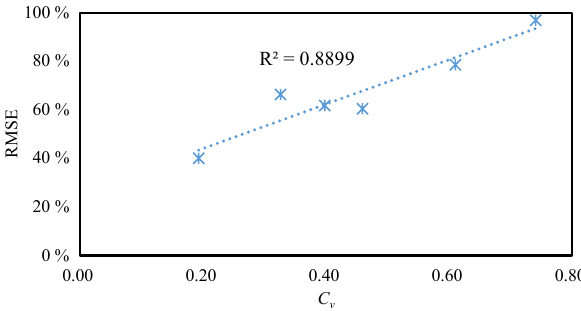
Figure 6. The relationship between RMSE and Cv in the spatial